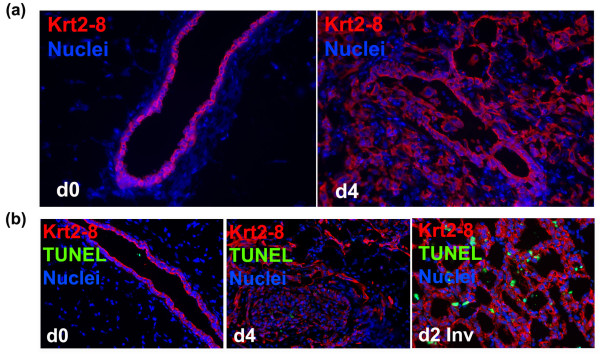
Cytokeratin 8 expression and apoptosis in the mammary gland following Ras activation. (a) Immunofluorescence staining for cytokeratin 8 (Krt2-8) in the mammary gland at d0 and d4 following oncogenic Ras activation revealed no significant changes in its expression within epithelial cells. (b) TUNEL analysis showing that Ras activation does not increase apoptosis rates in the mammary glands following four days of Ras activation.